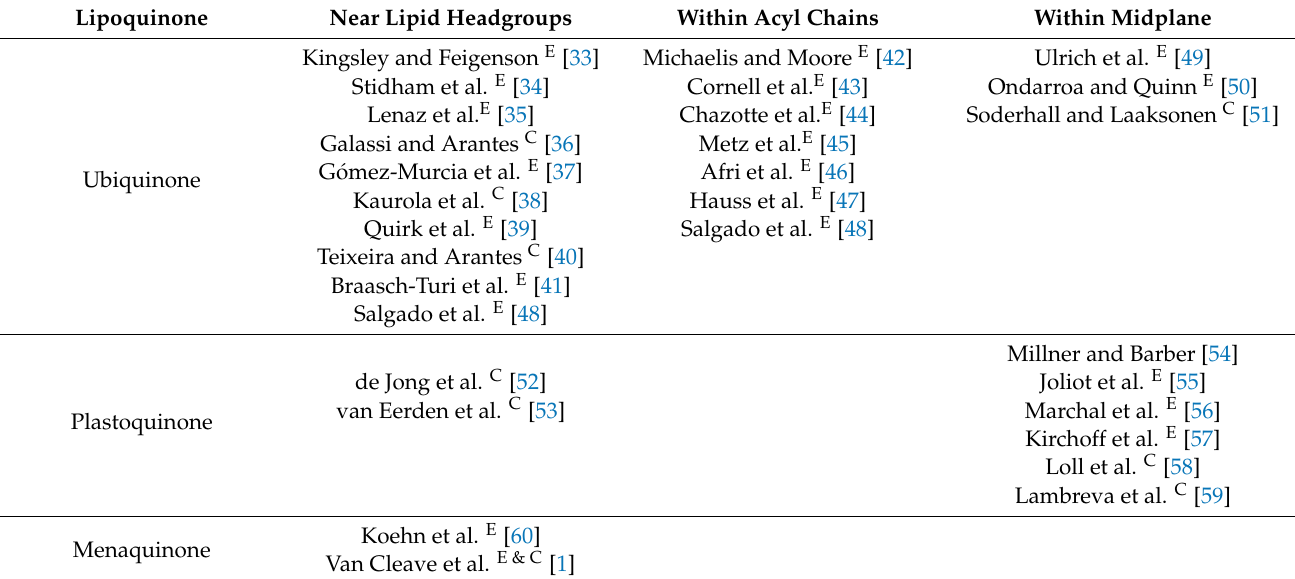
Figure 2. Space-filling model of UQ-10 (C 59 H 90 O 4 ) (top) and model bilayer of dipalmitoylphos- phatidylcholine (DPPC) (16:0) (bottom). Illustration was inspired by a figure that appeared in Ref. [32]. Table 1. Summary of references regarding the membrane location of the quinone headgroup in lipoquinones. Experimental studies will be noted with superscripted “ E ”, and computational studies will be denoted with superscripted “ C